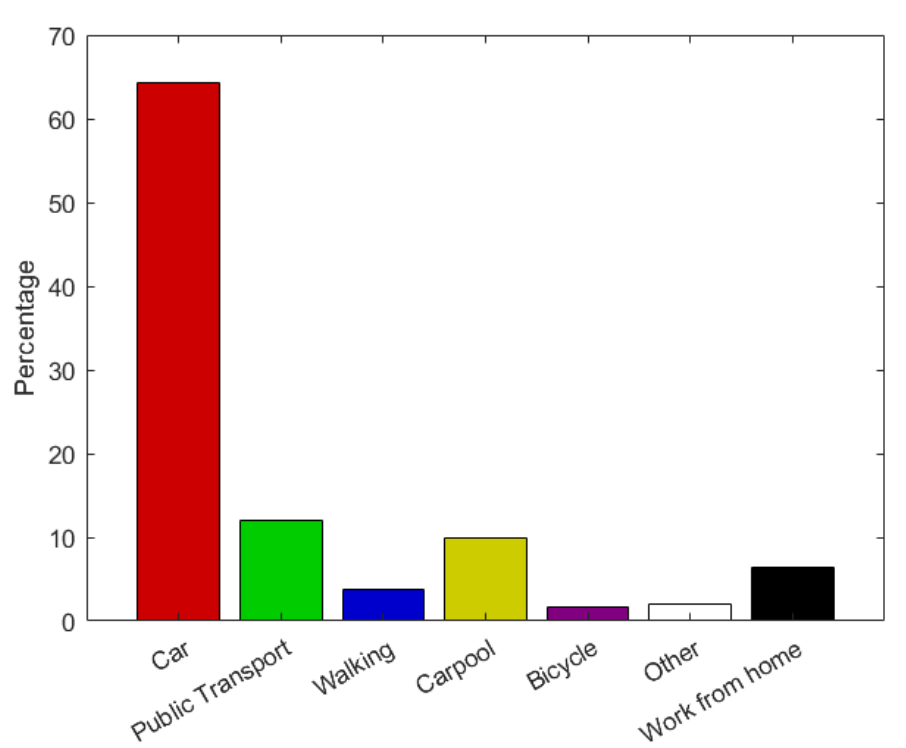
Figure 3. Mode share of the San Francisco Bay Area. Source: